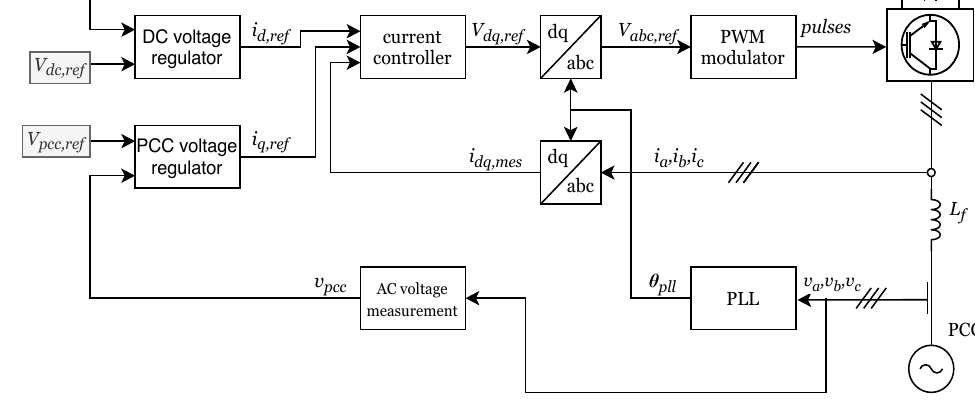
Figure 4. Vector control block